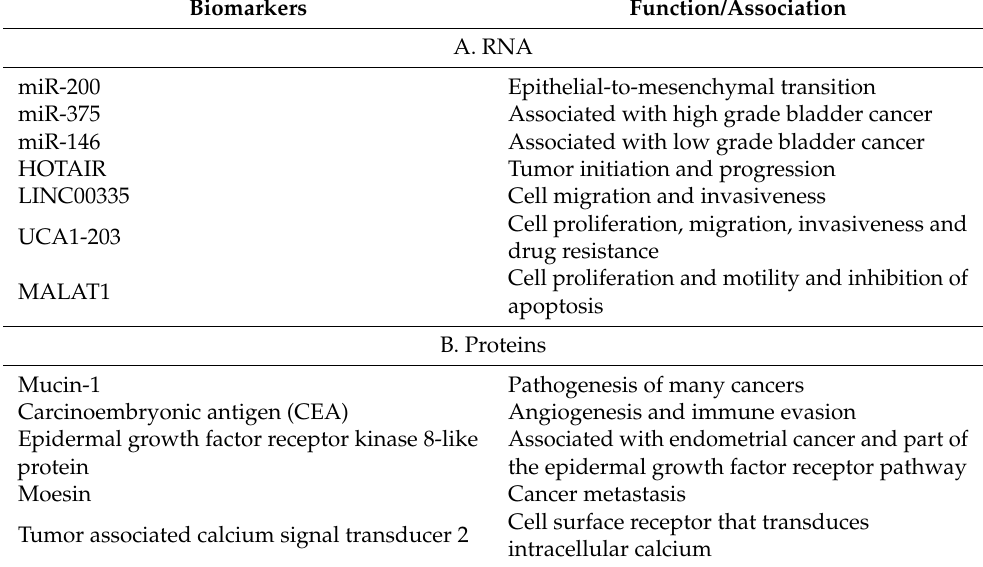
Table 1. Table summarizing contents of urine derived extracellular vesicles as potential biomarkers in cancer reserach. ( A ) Summary of extracellular vesicle RNA biomarkers and their functions. ( B ) Summary of extracellular vesicle protein biomarkers and their